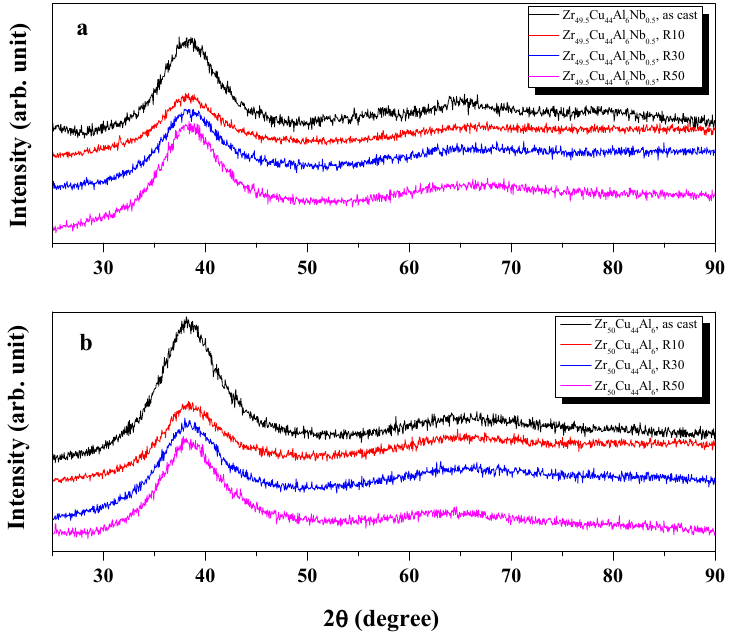
Figure 1. XRD patterns of ( a ) Zr 49.5 Cu 44 Al 6 Nb 0.5 and ( b ) Zr 50 Cu 44 Al 6 ribbons.